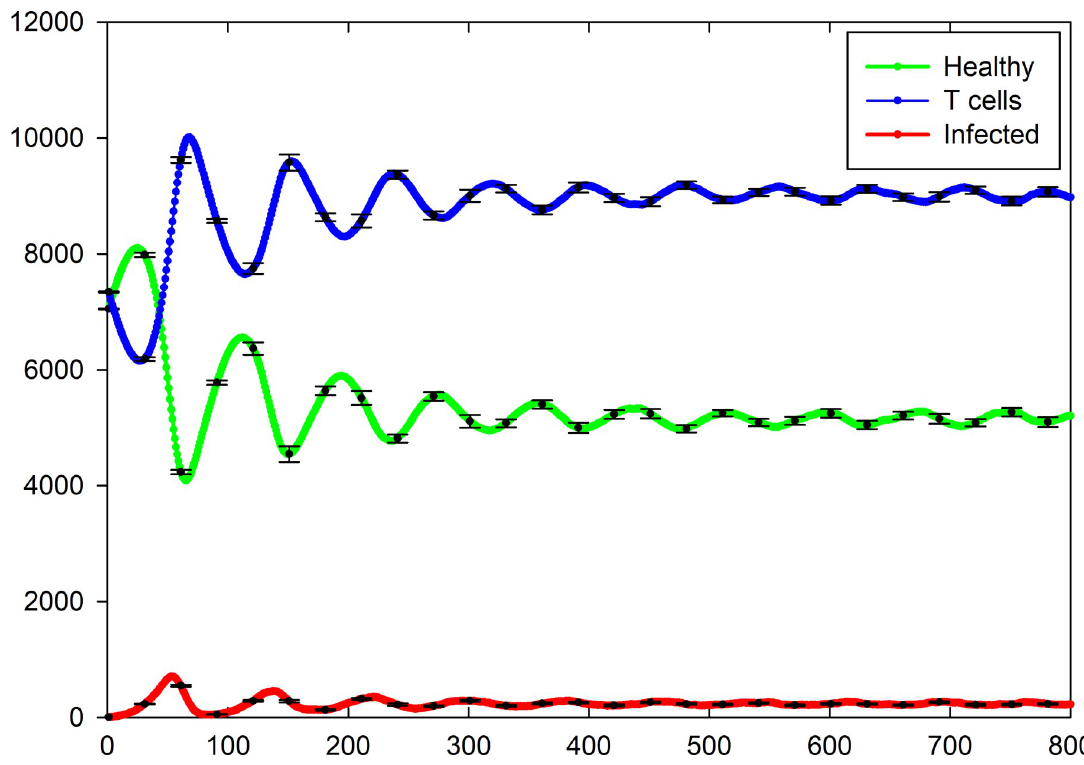
Fig 10. Total number of healthy, infected, and T cells versus time which are calculated by averaging over 39 samples with oscillating dynamics, for the case of P I = 1, P T = 0.4, P H = 0.4, and P D = 0.01. The standard errors are shown by error bars.